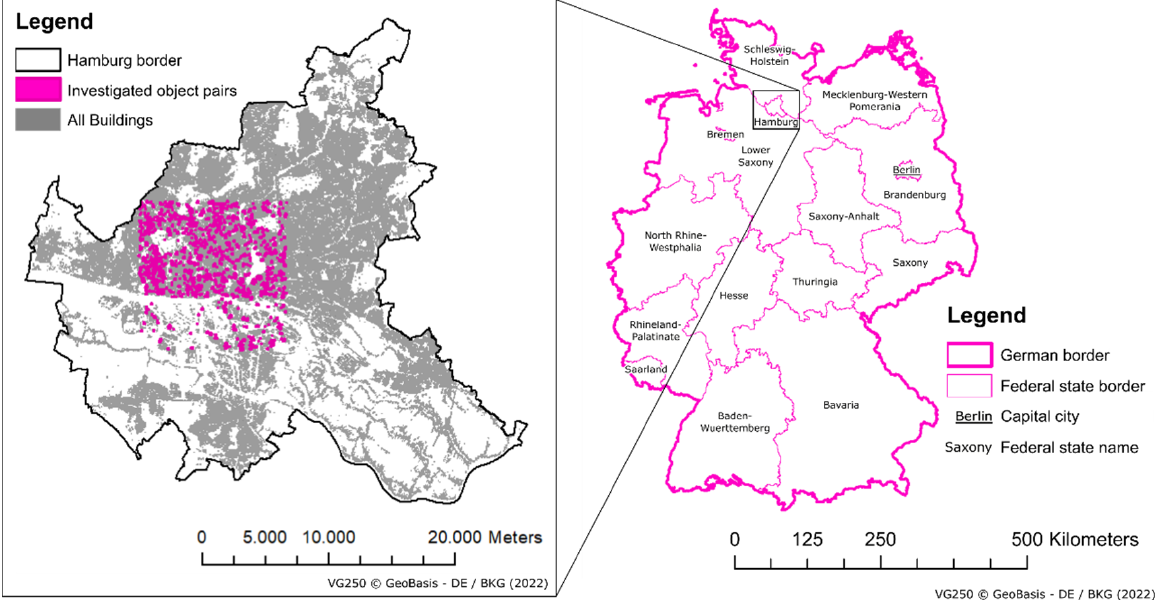
Figure 2. Study area, city of Hamburg (2015–2018); investigated intersection polygons of nonidentical object-pairs (n = 2285) highlighted in pink on the left side.